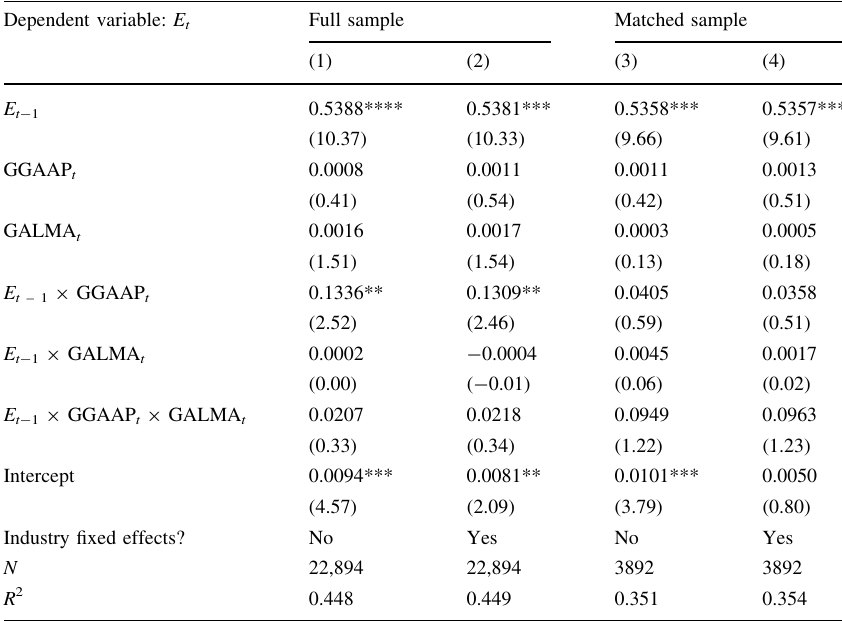
Table 9 Third financial reporting property—persistence of